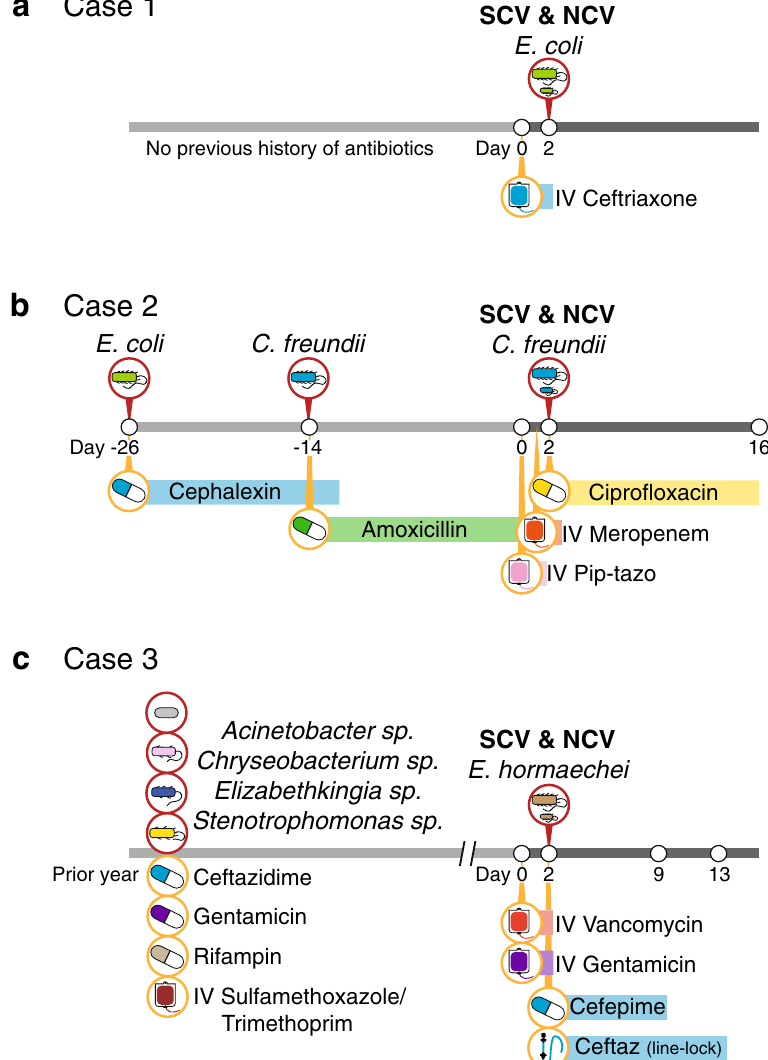
Figure 1. Case histories. Relevant past clinical microbiological and antibiotic selective pressures are indicated in the line histories for the isolation of NCV and SCV in Escherichia coli ( a ), Citrobacter freundii ( b ), and Enterobacter hormaechei ( c